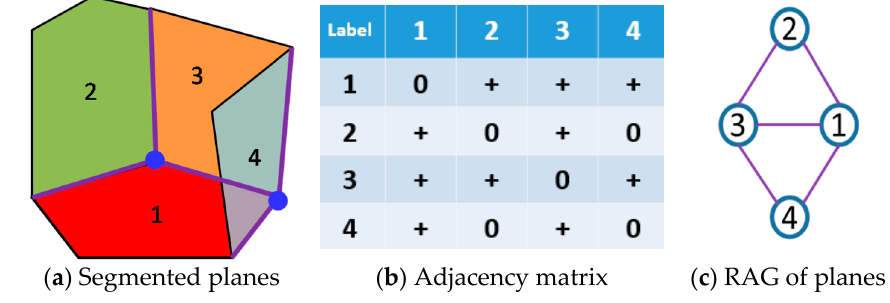
Figure 7. RAG of segmented planes.